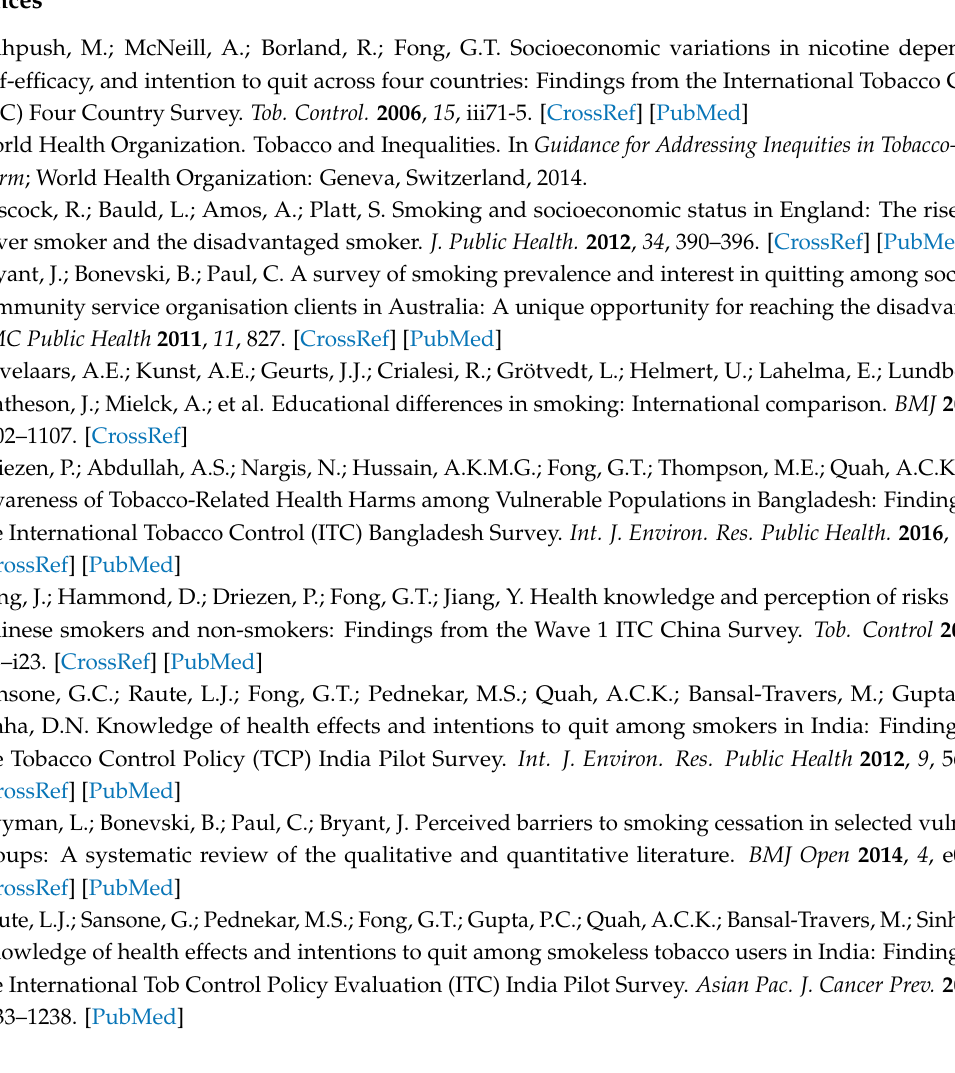
Table S1: Characteristics of the study